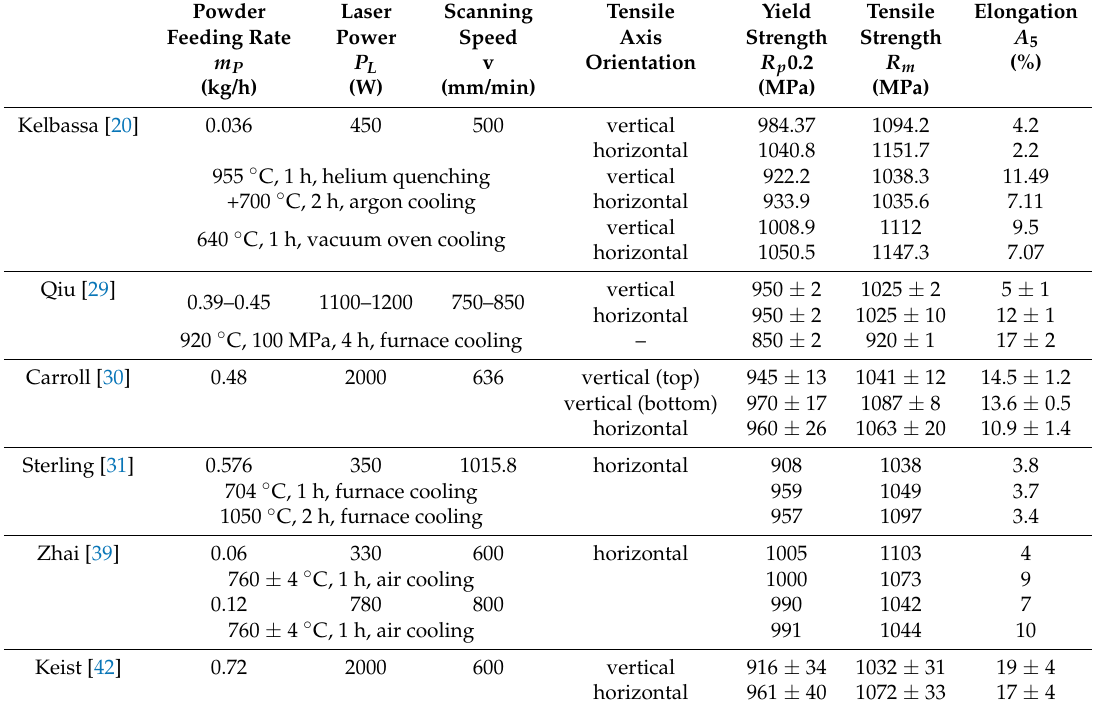
Table 4. Mechanical properties of specimens of Ti6Al4V fabricated by